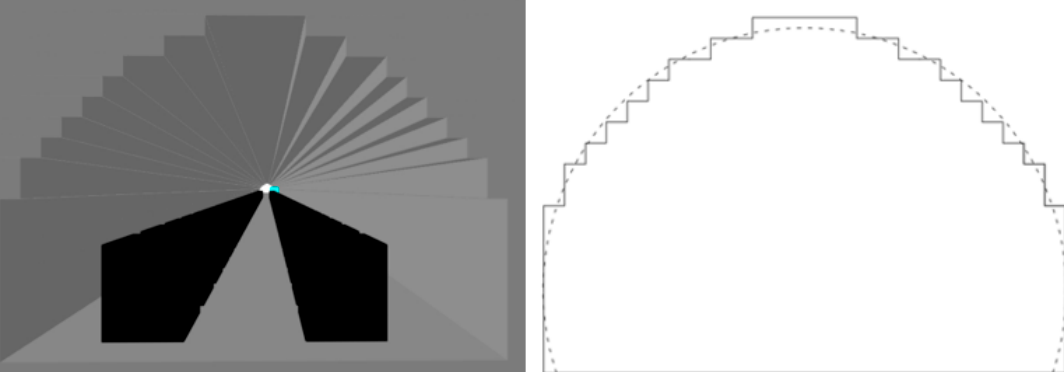
Figure 1. View of the tunnel simulated by means of FDS.